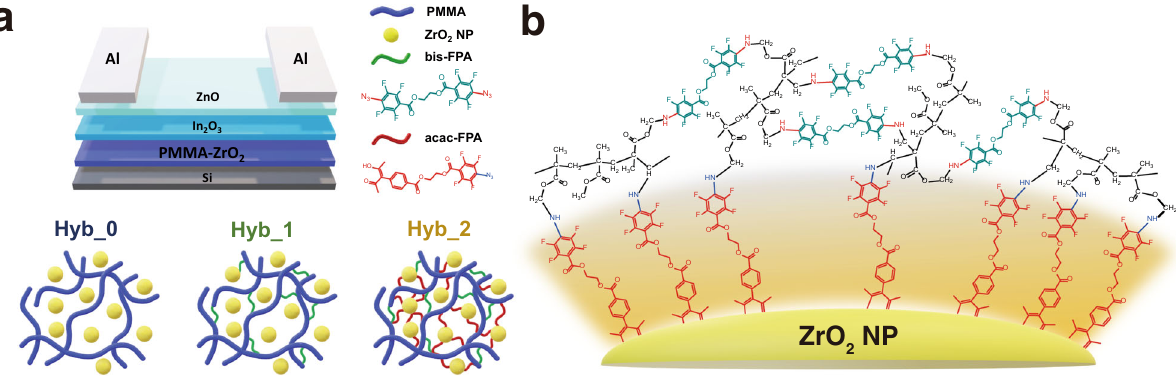
Fig. 1 | Schematic diagram of oxide TFT with hybrid dielectric using a cross- linking ligand. a Structureof In 2 O 3 /ZnOheterojunctionTFT with PMMA-ZrO 2 asa gate dielectric (top)and molecular structureofHyb_0,Hyb_1, andHyb_2 (bottom).